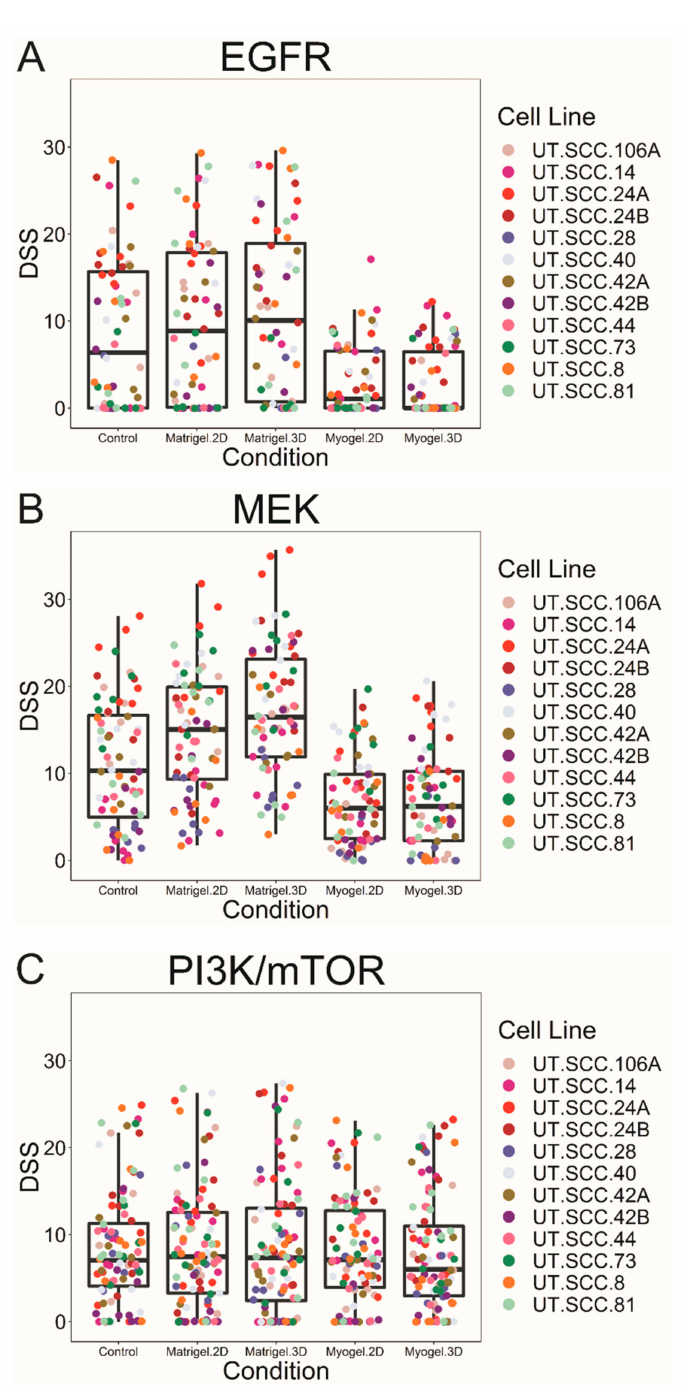
Figure 1. Box plots of the average drug-sensitivity score (DSS) values for each cell line clustered according to the drug group and the culturing condition. Cancer cells on top of and embedded in Myogel were less responsive to EGFR ( A ) and MEK inhibitors ( B ) compared to the cells cultured on two-dimensional (2D) plastic or Matrigel. However, for the PI3K and mTOR inhibitors ( C ), we observed a similar e ffi cacy for the drugs under all culturing